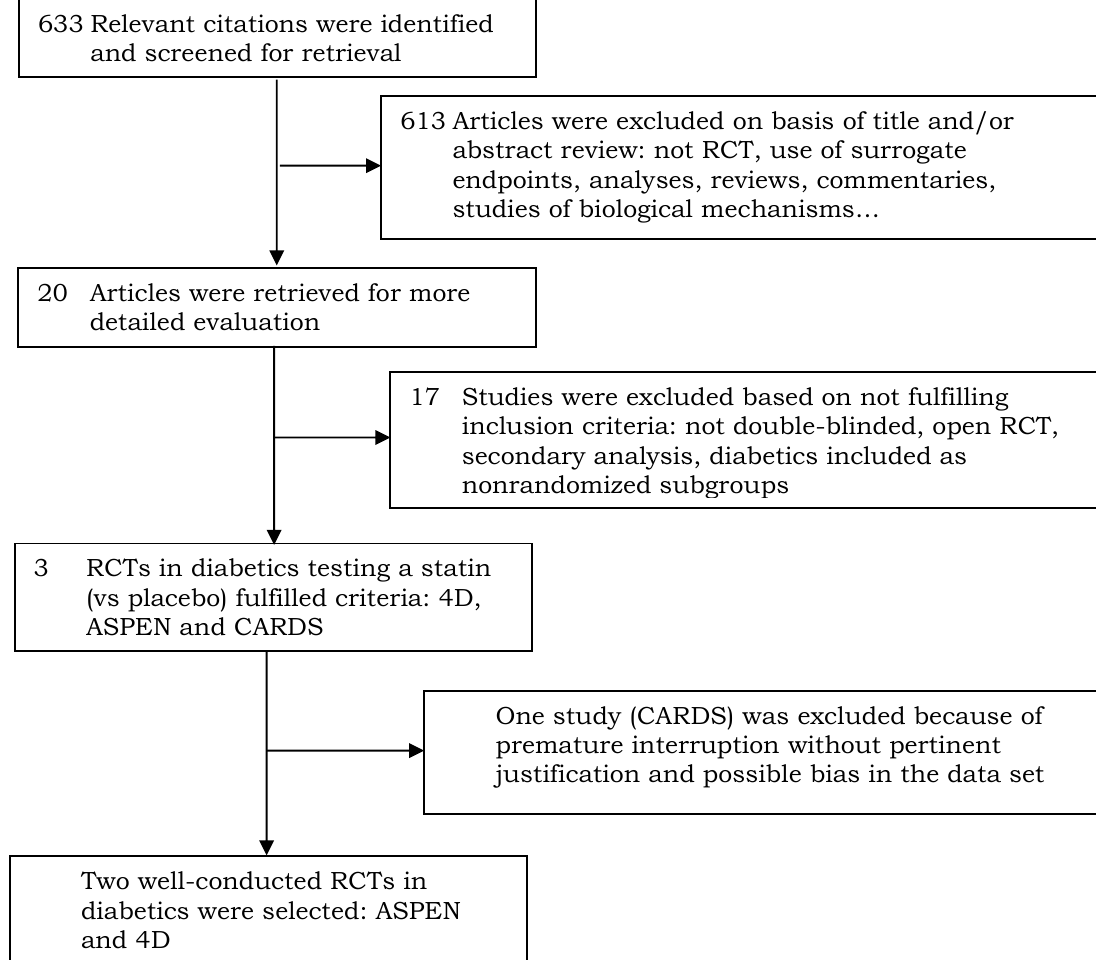
Figure 2. Flow diagram of selection of statin RCTs testing a statin against placebo in diabetic patients. This an extension of a systematic review published in 2012 (104). Inclusion and exclusion criteria are the same as those used in our previous systematic review (104), with a special attention to studies reporting secondary and subgroup